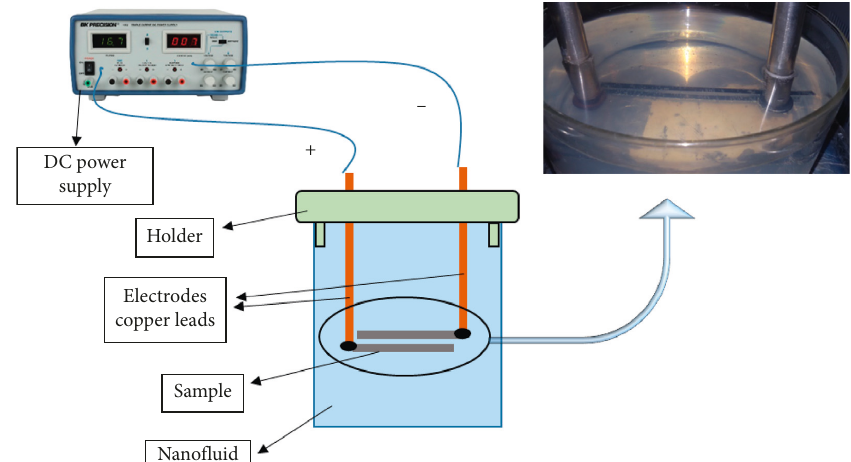
Figure 1: A schematic of EPD setup.